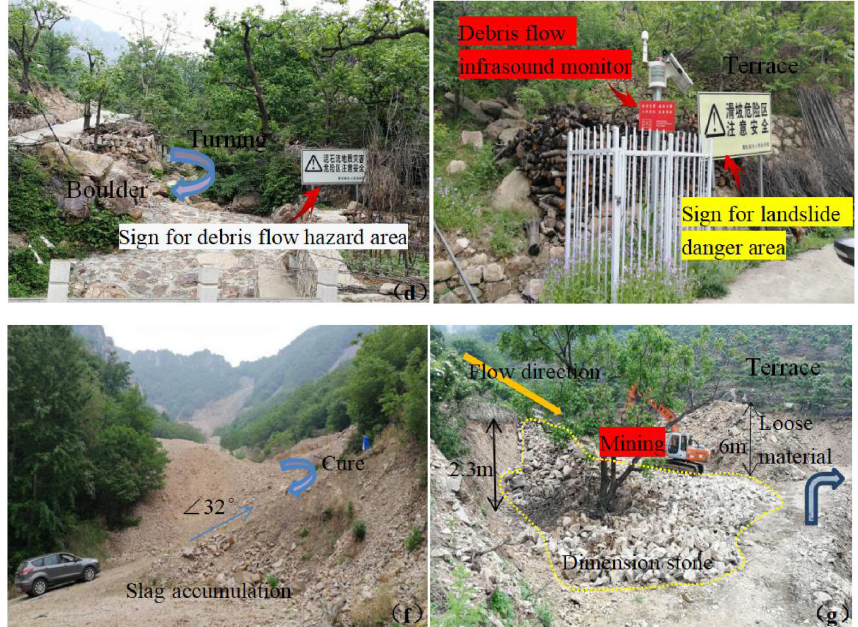
Figure 4. Huangsongyu National Mining Park. d is debris flow hazard area, e is debris flow monitoring instrument, f is loose slag accumu- lated in formation area and g is excavator